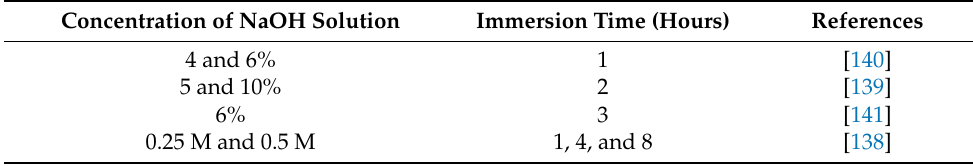
Table 5. Research on alkalisation of SPF with various concentrations and immersion times. Concentration of NaOH